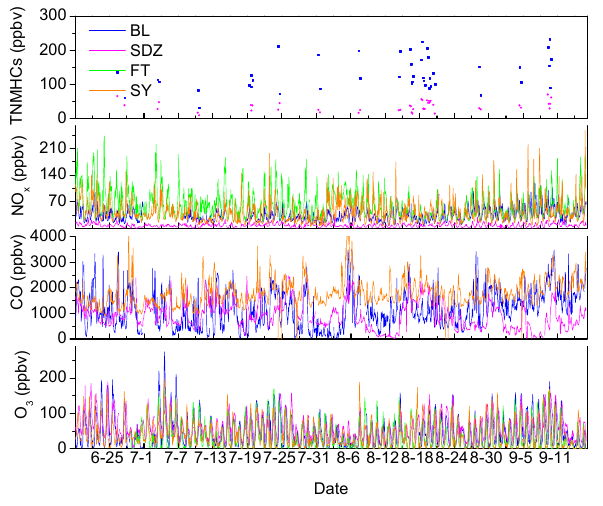
Fig.3. Time series of hourly averaged TNMHCs, NO x , CO and O 3 concentrations at the four 2 Fig. 3. Time series of hourly averaged TNMHCs, NO x , CO and O 3 sites. 3 concentrations at the four sites.